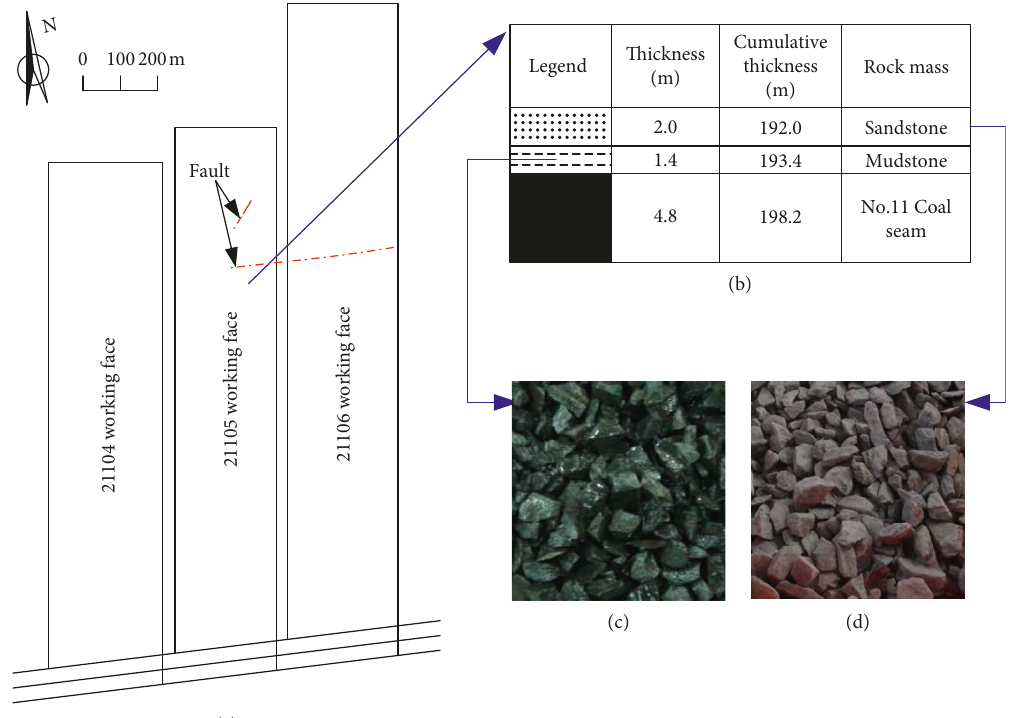
Figure 1: Illustration of the geological conditions and sample material showing (a) working faces of the Pingshuo coal mine, (b) borehole log showing the lithologies, (c) crushed mudstone, and (d) crushed